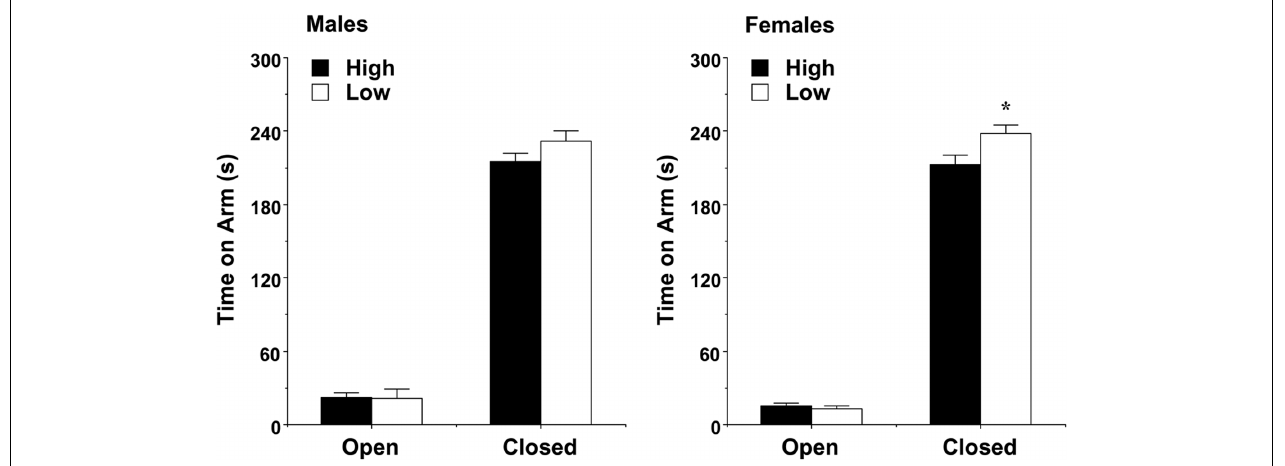
FIGURE 4 |Time spent on the open and closed arms of the elevated plus-maze (mean + SEM) during a 5-min test. Female offspring of dams with low levels of pup-licking spent significantly more time in the closed arms than the offspring of high-licking dams. * p <